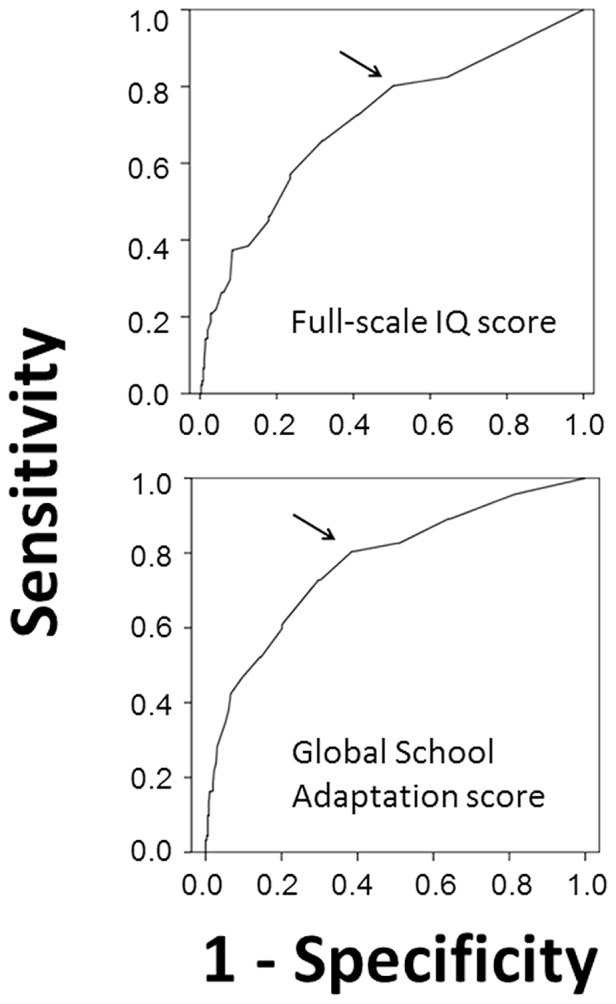
Receiver Operating Characteristic curves for predicting full-scale IQ score<85 and GSA score in first quintile based on ASQ values.Arrows denote optimal cut-off values (ASQ score of 285 for the two curves).